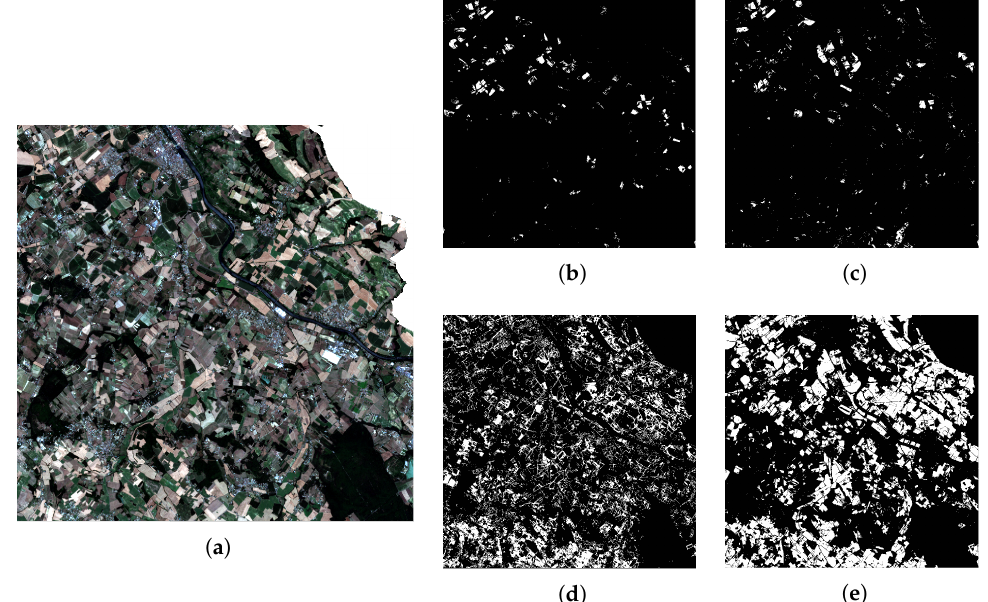
Figure 9. A second visual evaluation zone with (a) its RGB composite and the corresponding binary classification maps for (b) RF PUL , (c) ENSEMBLE PUL , (d) OCSVM and (e) PUL-SITS for the positive class Cereals/Oilseeds with a number of positive training data objects ( n ) equals to 80.